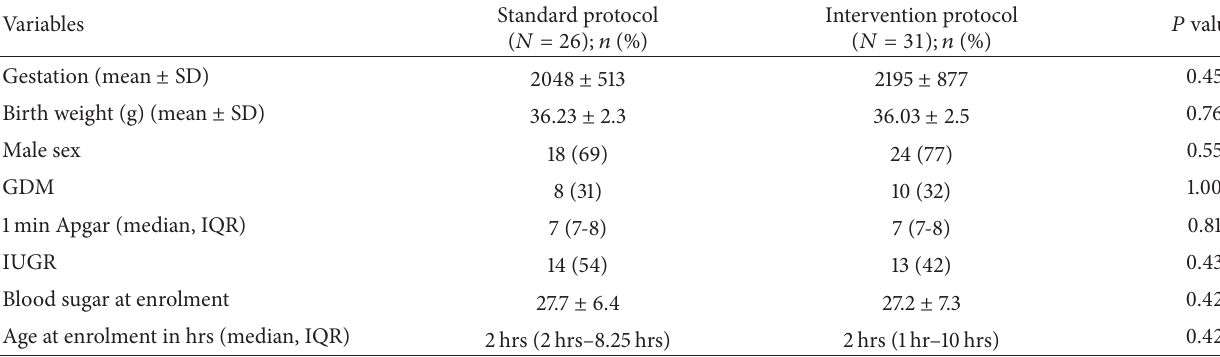
Table 1: Comparison of baseline variables between the study